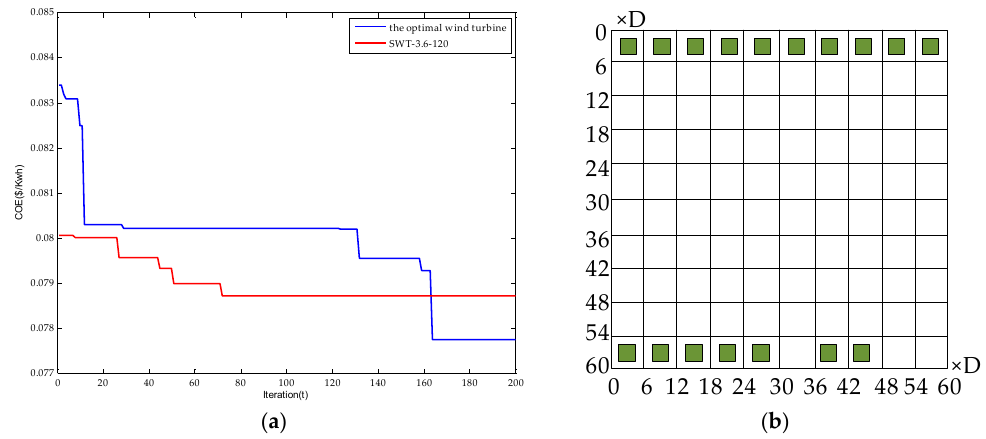
Figure 5. The results of the objective function (COE) and optimal layout: ( a ) result of objective function